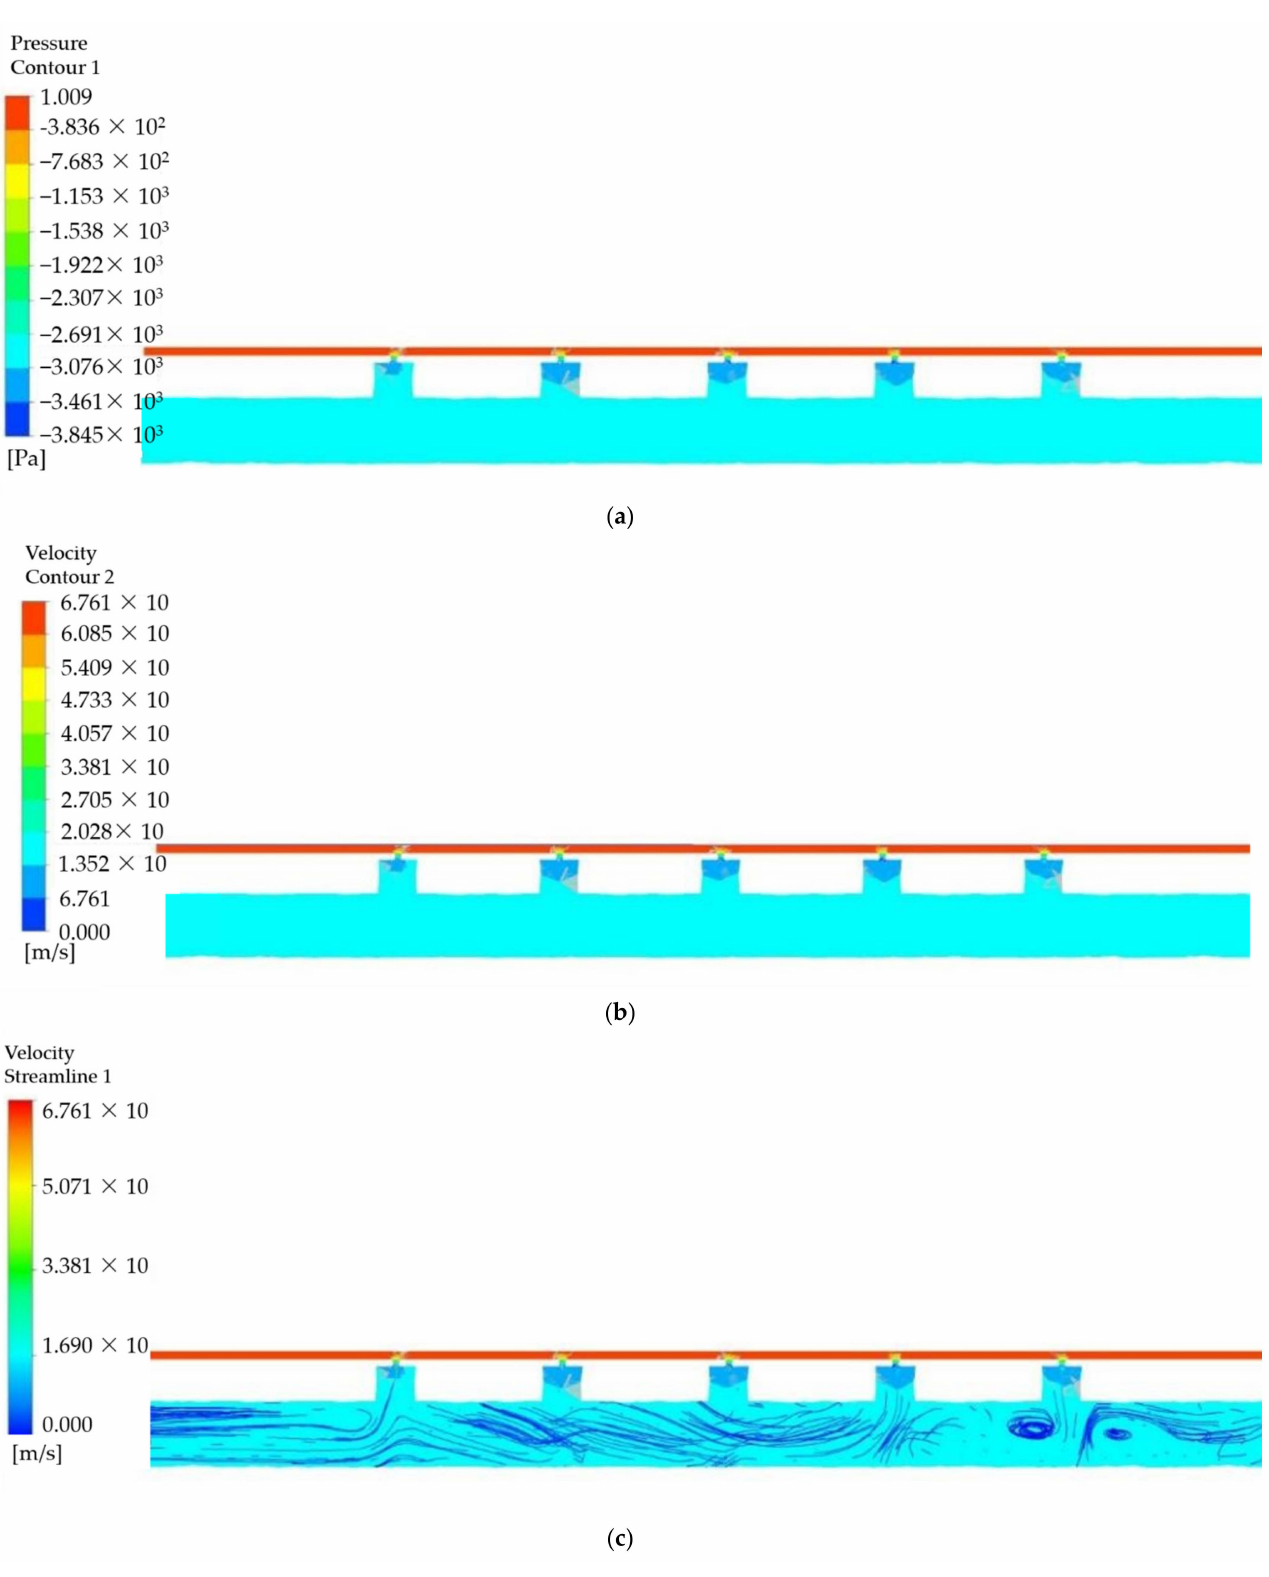
Figure 6. ( a ) The cloud charts of pressure distribution about a 2 mm wedge hole; ( b ) The cloud charts of velocity distribution about a 2 mm wedge hole; ( c ) The streamline diagram of velocity about a 2 mm wedge